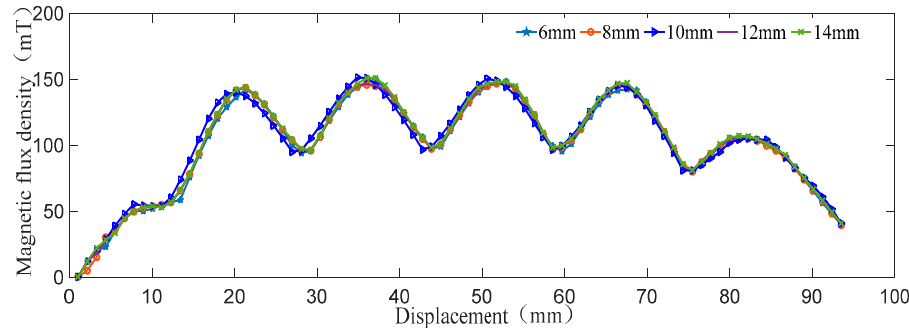
Figure 7. Effect of the fixed plug’s thickness on the magnetic flux density.